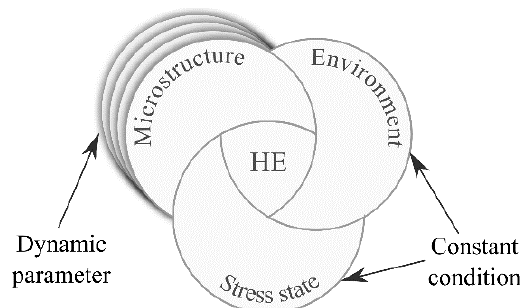
Figure 1. The overview of the conditions considered as the parameters controlling the hydrogen embrittlement in steels in the developed approach.